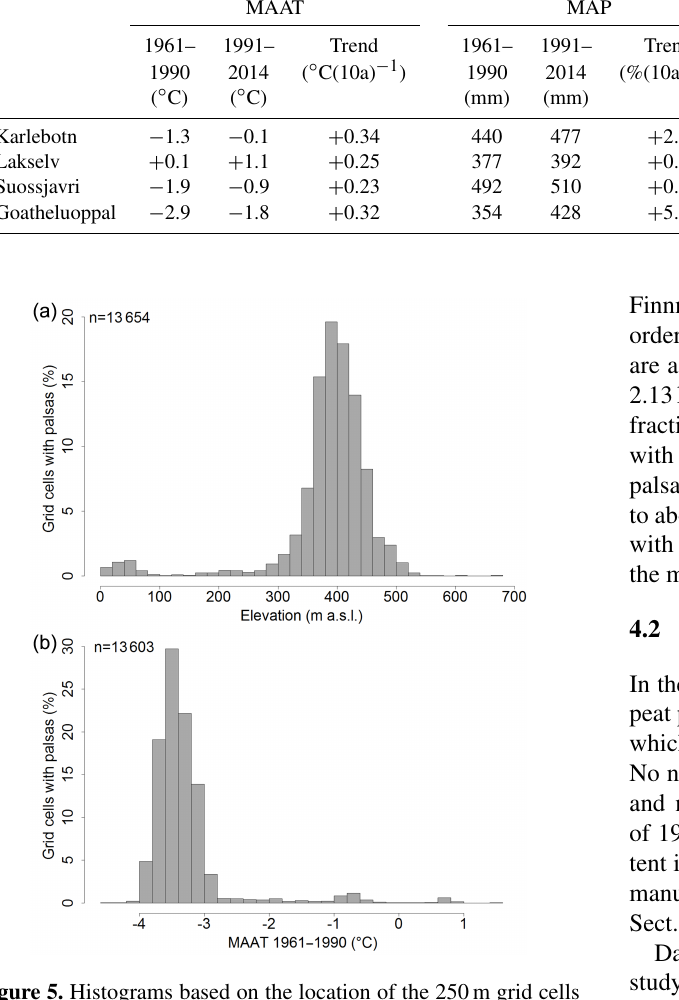
Figure 5. Histograms based on the location of the 250m grid cells with presence of palsas and peat plateaus for (a) gridded data of the minimum elevation (Kartverket, 2015b) in each grid cell and (b) gridded data of mean annual air temperature (MAAT) for 1961– 1990 (seNorge, 2016). The number of grid cells used in the his- tograms deviate slightly from the mapped number of grid cells with palsas due to insufficient covering close to the coast and to the Nor- wegian border of the gridded layers of MAAT and the digital eleva- tion